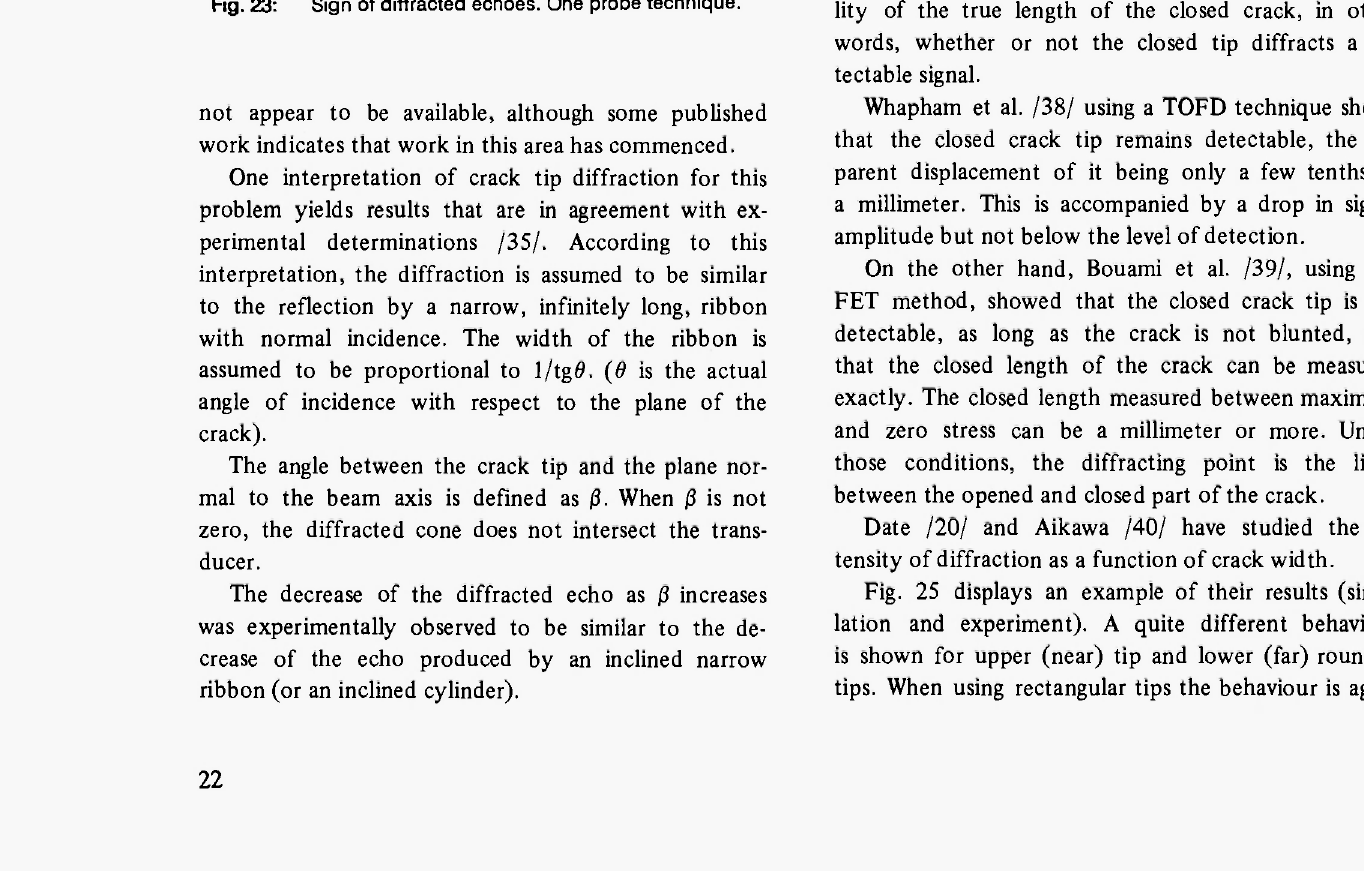
Fig. 23: Sign of diffracted echoes. One probe